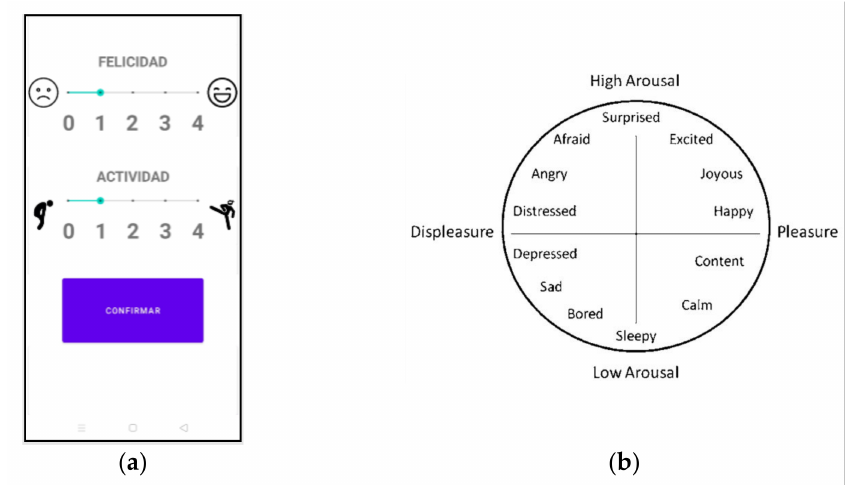
Figure 8. ( a ) Mobile application to collect mood states labels (on the left); ( b ) Affection state model [76].